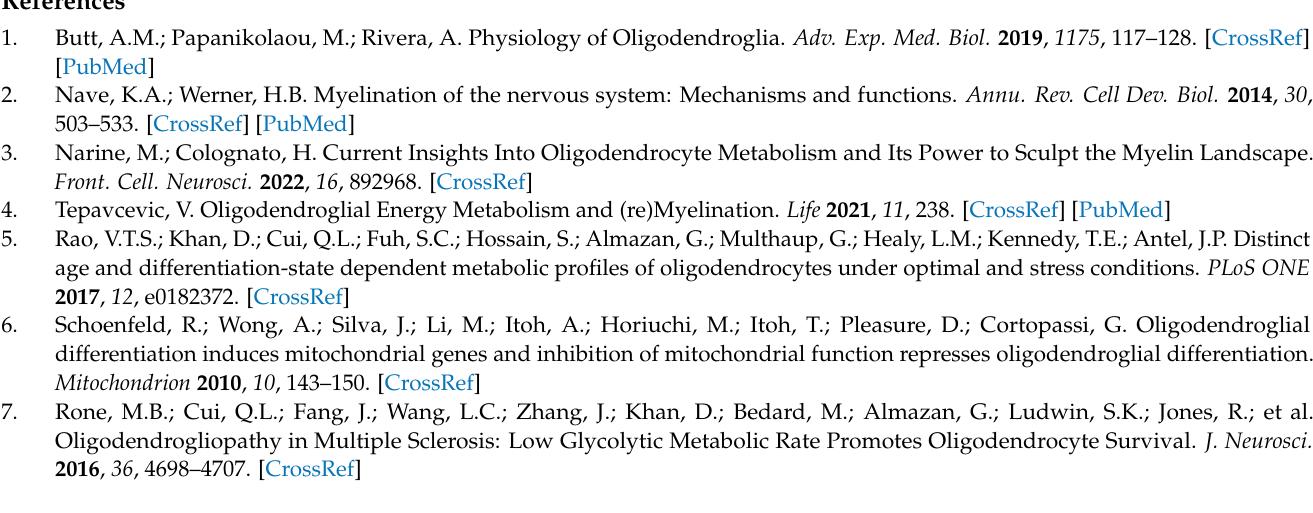
metabolomic analysis. Figure S3: Effect of AR-C155858 on lactate release; Table S4. Descriptive tables of lipidomic